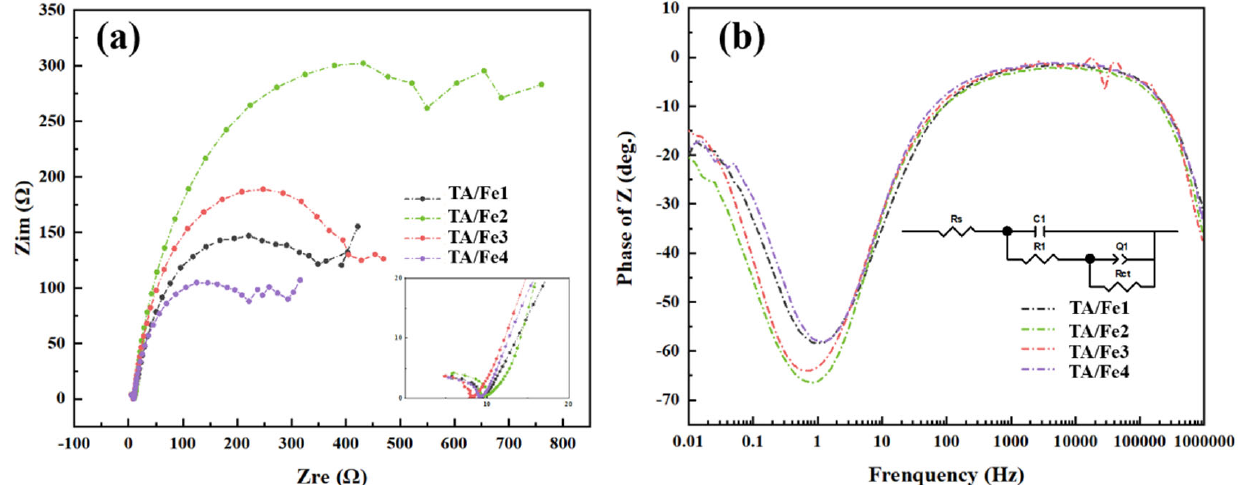
Figure 12. ( a ) Nyquist plots and ( b ) Bode diagrams of the titanium oxide ‐ based aerogel catalysts doped by different Fe sources. Table 4. Electrochemical impedance data of as ‐ prepared aerogel catalysts.